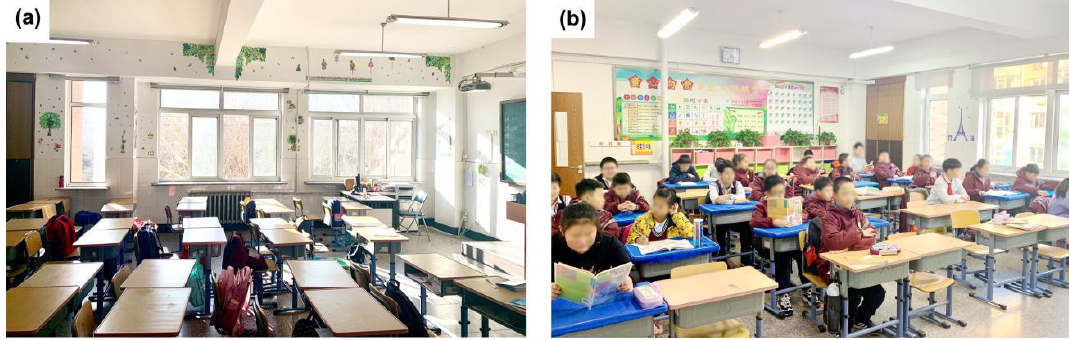
Figure 4. Classrooms selected for the measurements.( a ) Vacant classroom; ( b ) Occupied classroom. Table 1. Information on the selected classrooms.